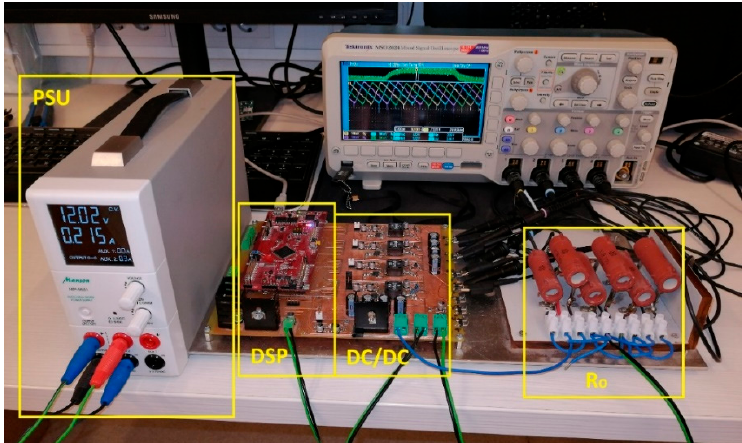
Figure 6. Test setup for prototype converter with ohmic load.